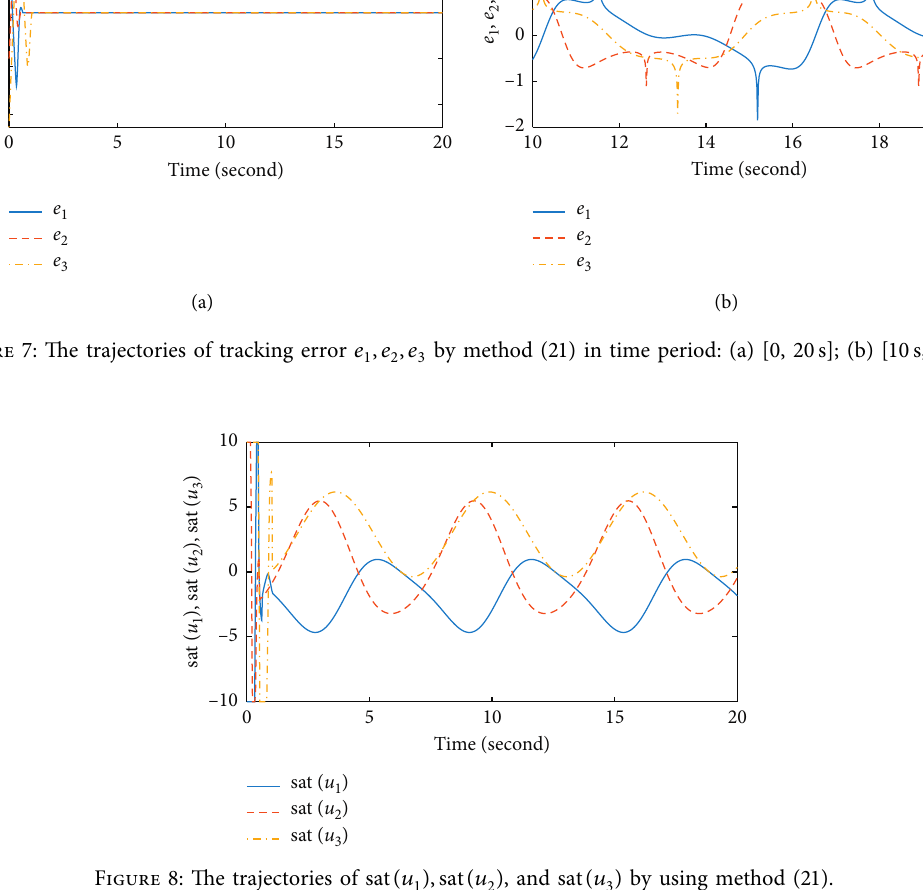
Figure 8: The trajectories of sat ( u